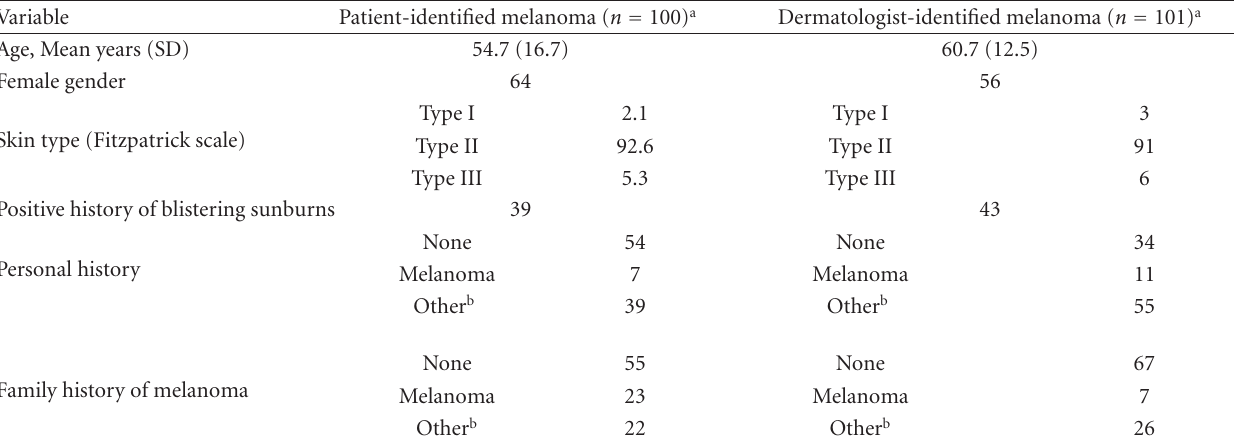
Table 1: Patient variables.